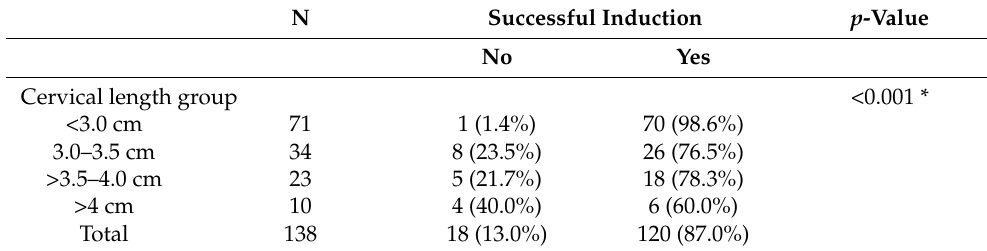
Table 3. Cervical length vs. successful induction (n = 138).